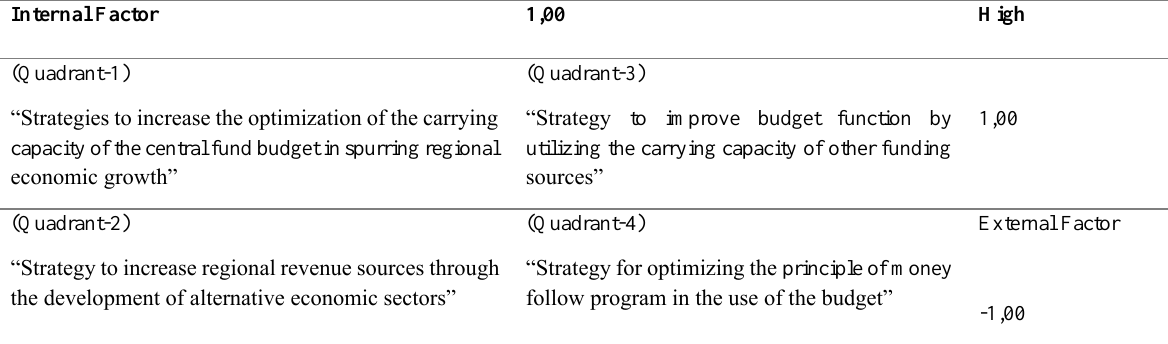
Table 4: Improvement Strategy of Financial Performance in